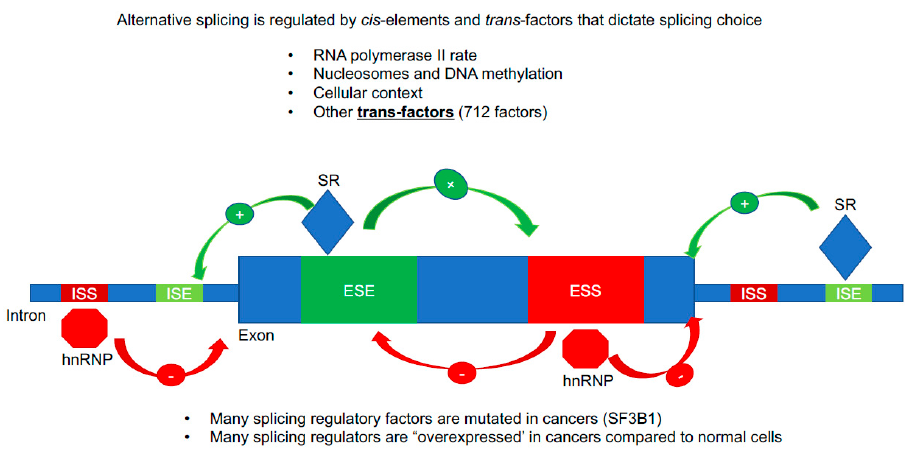
Figure 2. Alternative splicing regulation. A cartoon image of important sequence ( cis ) and protein ( trans ) regulatory features that result in exon inclusion or exclusion. The majority of the splicing information